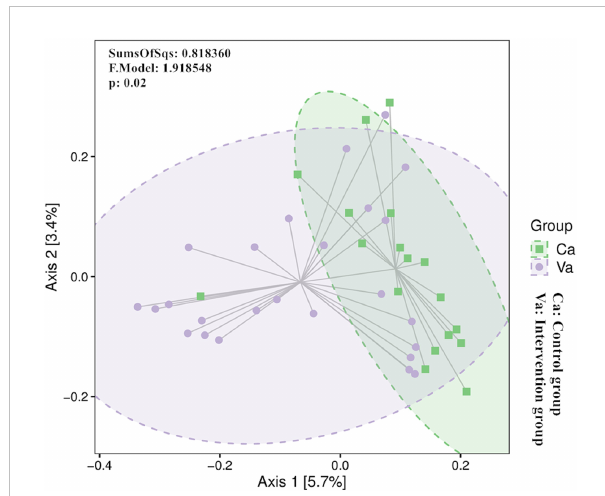
FIGURE 4 The PCoA of beta diversity based on the Bray − Curtis distance matrix revealed that the differences in community composition between the two groups were signi fi cant.